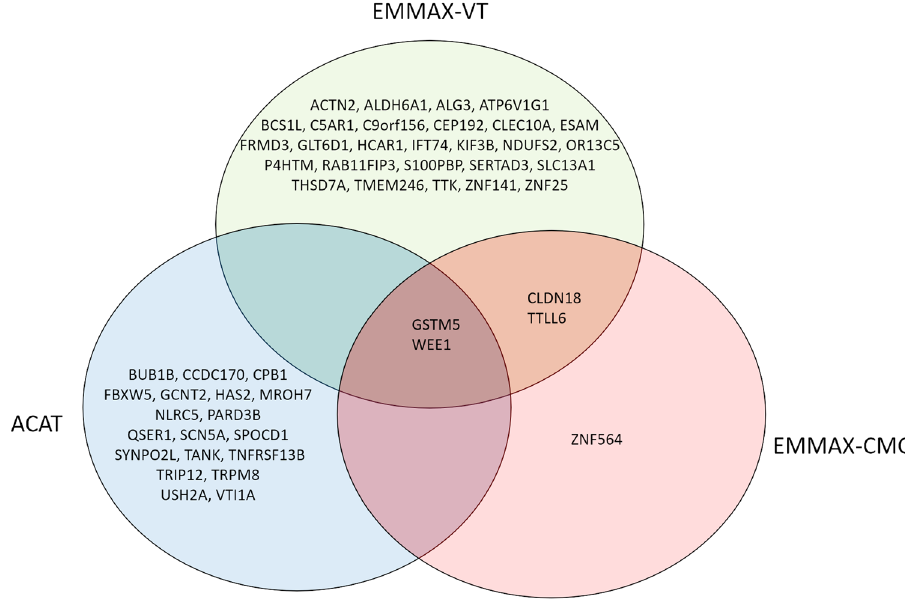
Fig. 6 Overlap between three tests in the Eastern Asian EACC analysis. A Venn diagram showing the overlap and unique signi fi cant genes in the EACC analysis using the three different tests: EMMAX-VT (green), EMMAX-CMC (red), and ACAT (blue). These plots are based on results in Supplementary Data 18 – 20.